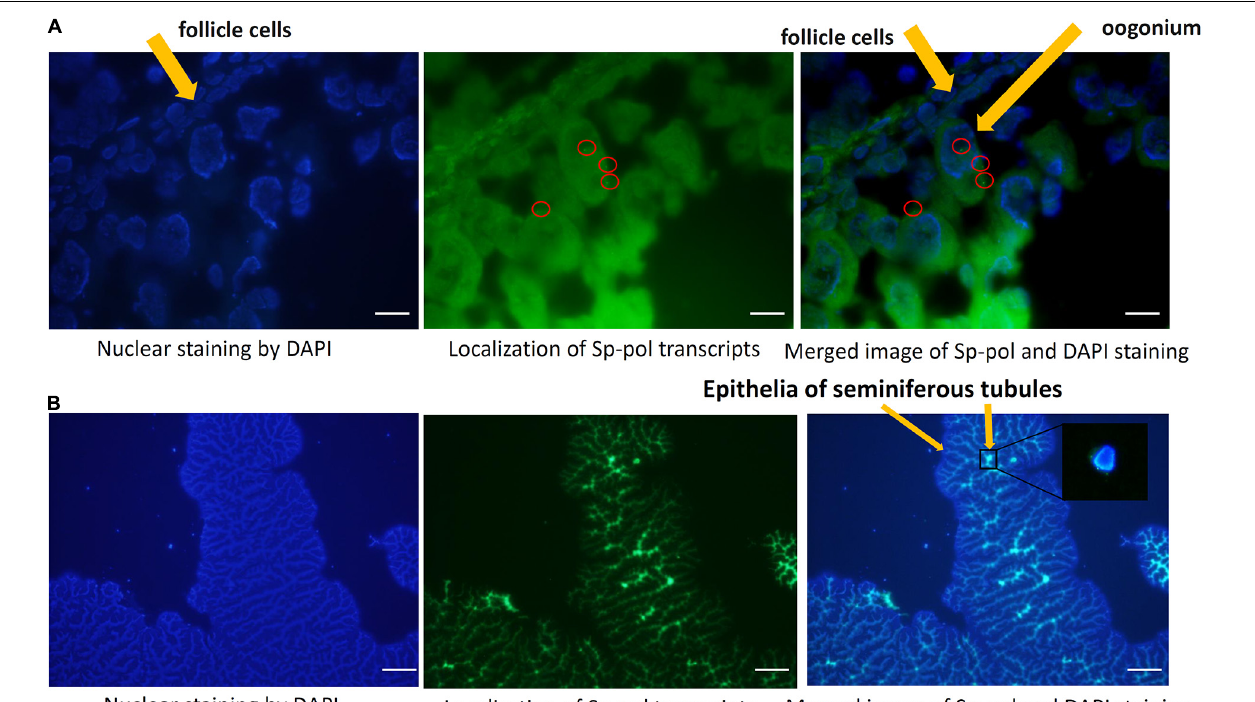
FIGURE 8 | Localization of Sp-Pol transcripts in the ovary (A) and testis (B) of Scylla paramamosain by FISH. (A,B) were captured at × 100 and × 10 magnification, respectively. Sp-Pol mRNA signals (green dots) are presented inside the red